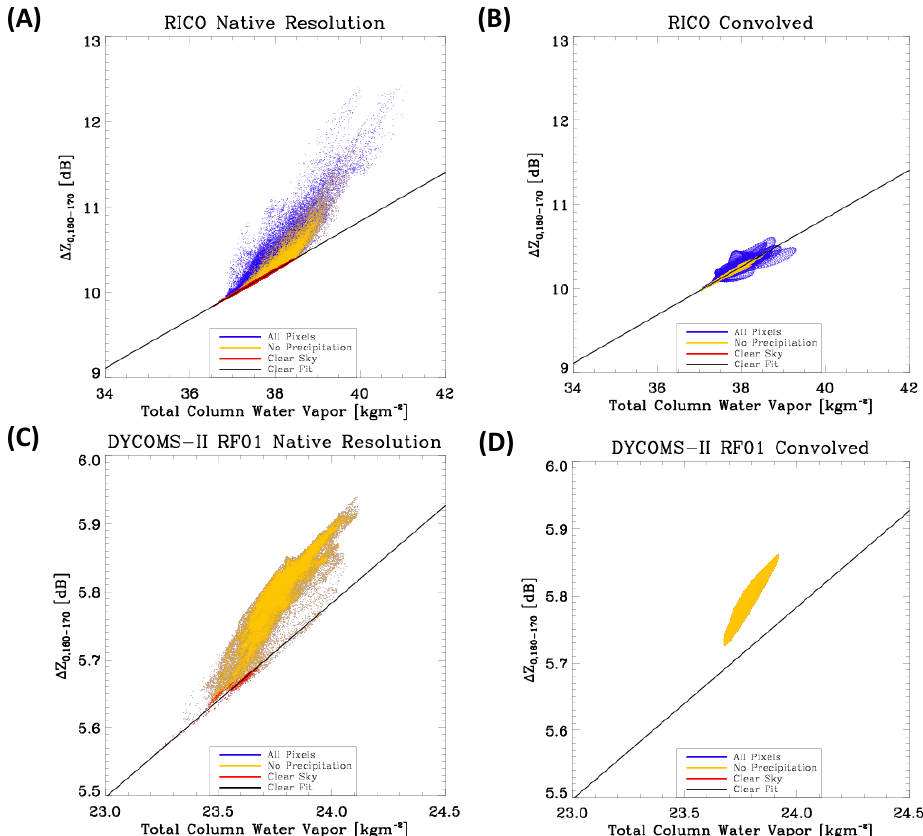
Figure 8. Scatter of the CWV against the reflectivity difference for the (160, 170)GHz channel pair for each simulation. Both the native resolution and the resolution averaged to the antenna gain function are shown. Non-precipitating columns and cloud-free pixels are distin- guished from precipitating columns. The black line shows a linear fit of the native resolution (cid:49)Z to the CWV for cloud free columns. Note that the RICO and DYCOMS-II RF01 plots have different